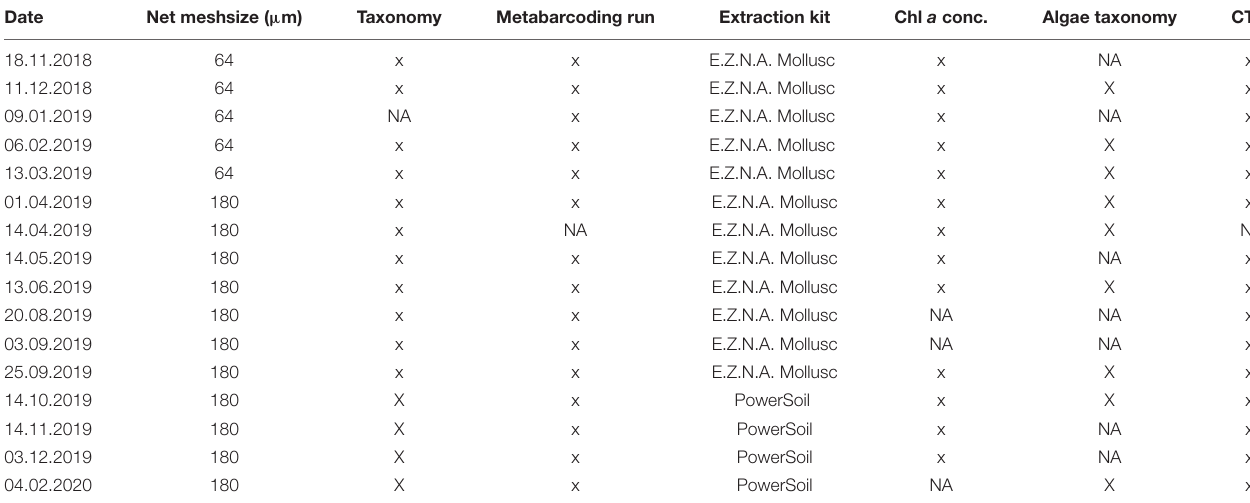
TABLE 1 | Overview of sampling date, method used and data available for each sampling point.